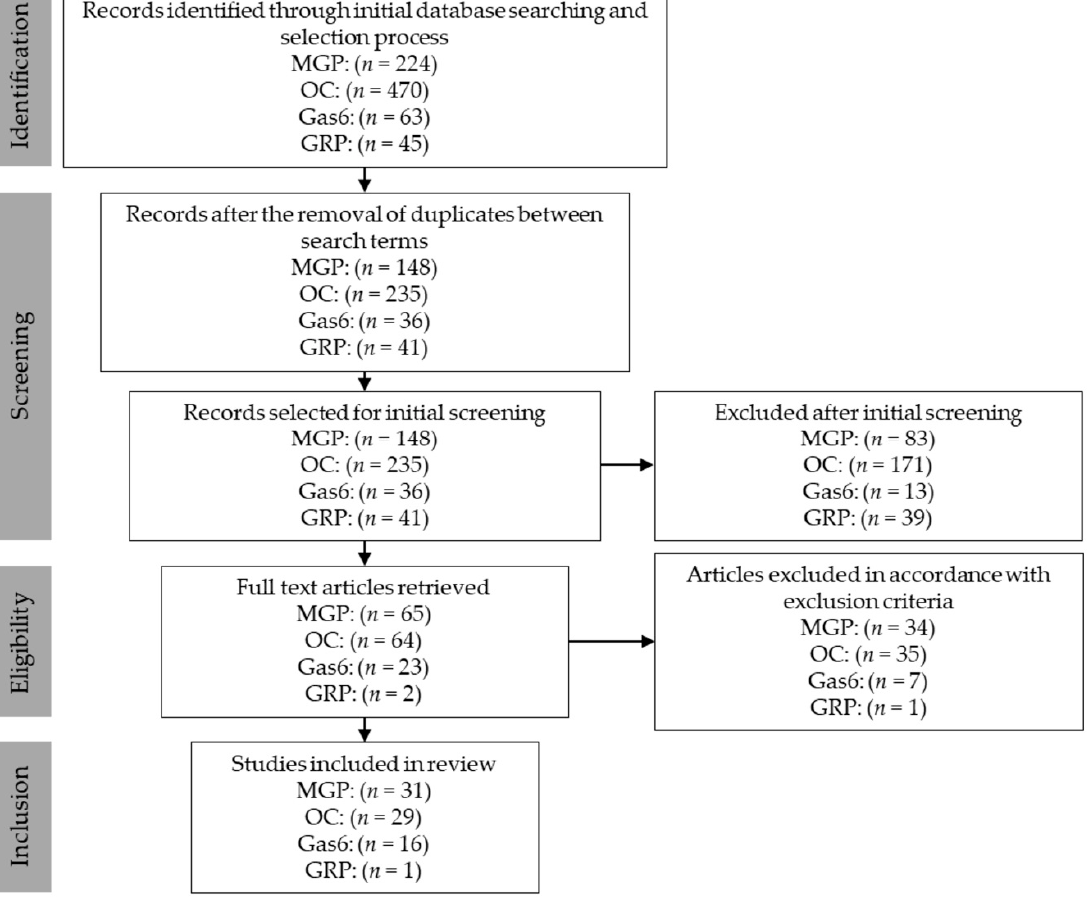
Figure 1. Flow diagram of the processes from identification, selection and screening to inclusion.